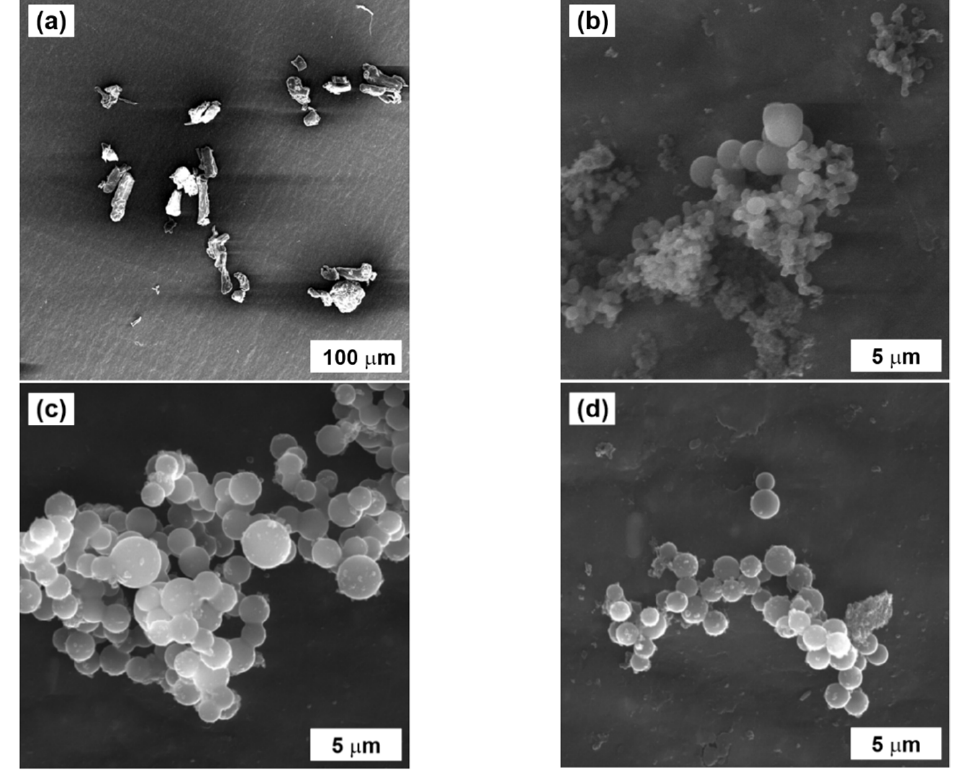
Figure 4. SEM images of ( a ) cellulose, ( b ) HTC-Cellulose, and ( c , d ) HTC-TC600-Cellulose particles.